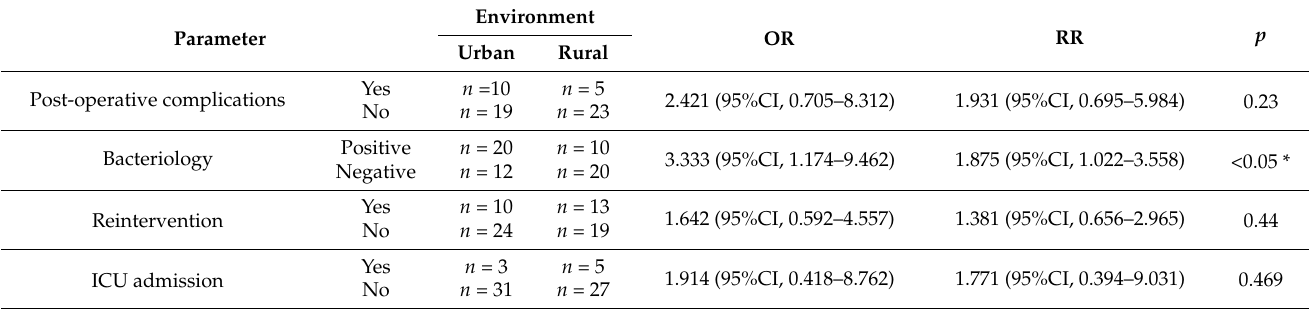
Table 5. Comparison of post-operative complications, bacteriology assay results, reintervention, and ICU admission between patients living in urban and rural